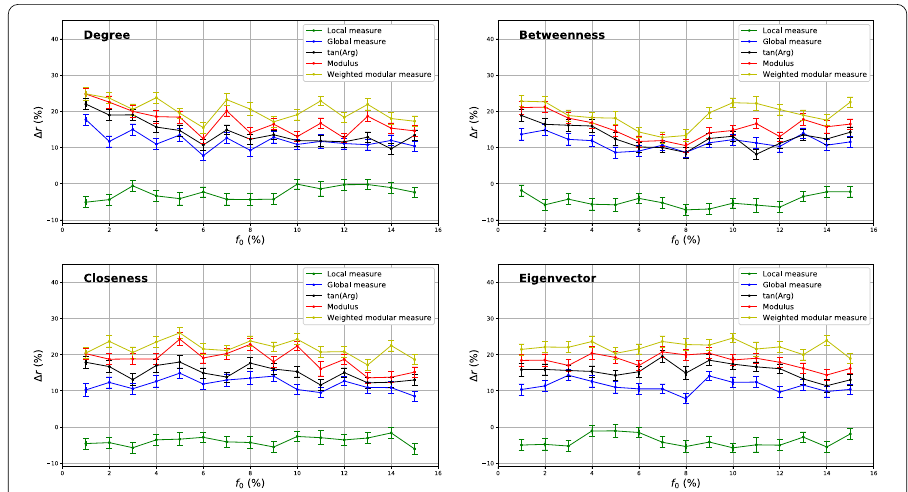
Figure 5 The relative difference of the outbreak size (cid:8) r as a function of the fraction of initial spreaders f 0 . The Degree ( a ), Betweenness ( b ), Closeness ( c ) and Eigenvector ( d ) centrality measures derived from the Modular centrality are compared to the standard counterpart designed for networks with no community structure. A real-world networks with weak community structure (Georgetown) is used. The estimated value of its mixing coefficient is equal to